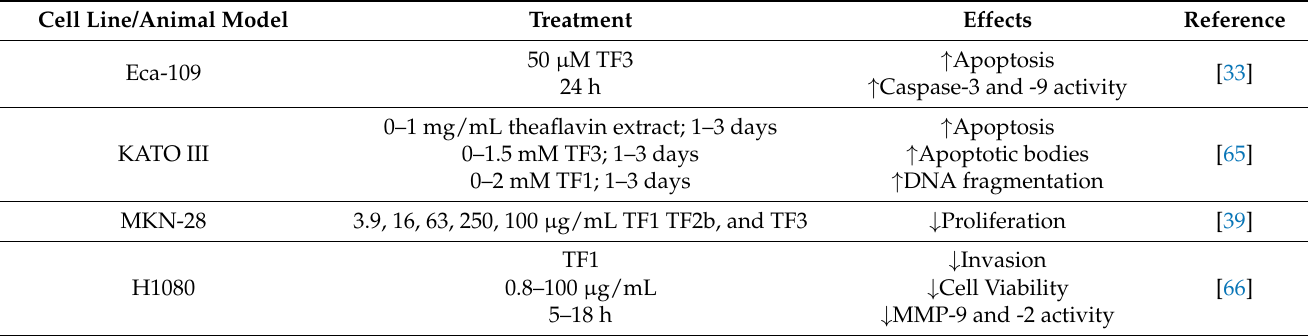
Table 10. Effects of theaflavins in esophageal cancer, stomach cancer and